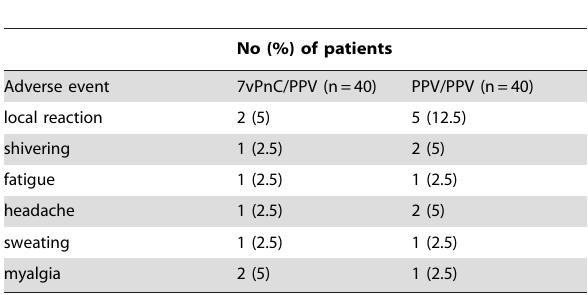
Table 2. Local and systemic reaction to